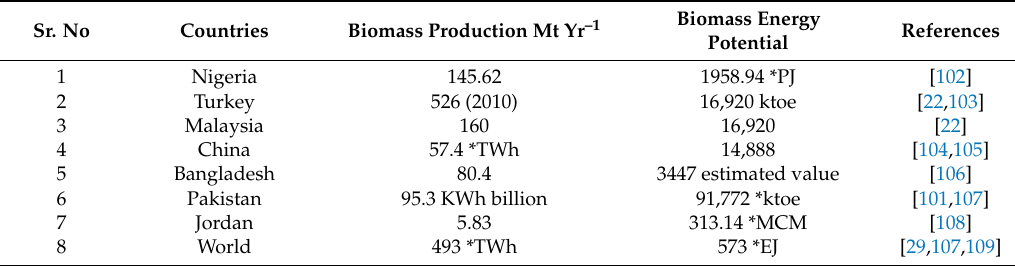
Table 15. Biomass production and energy potential in various